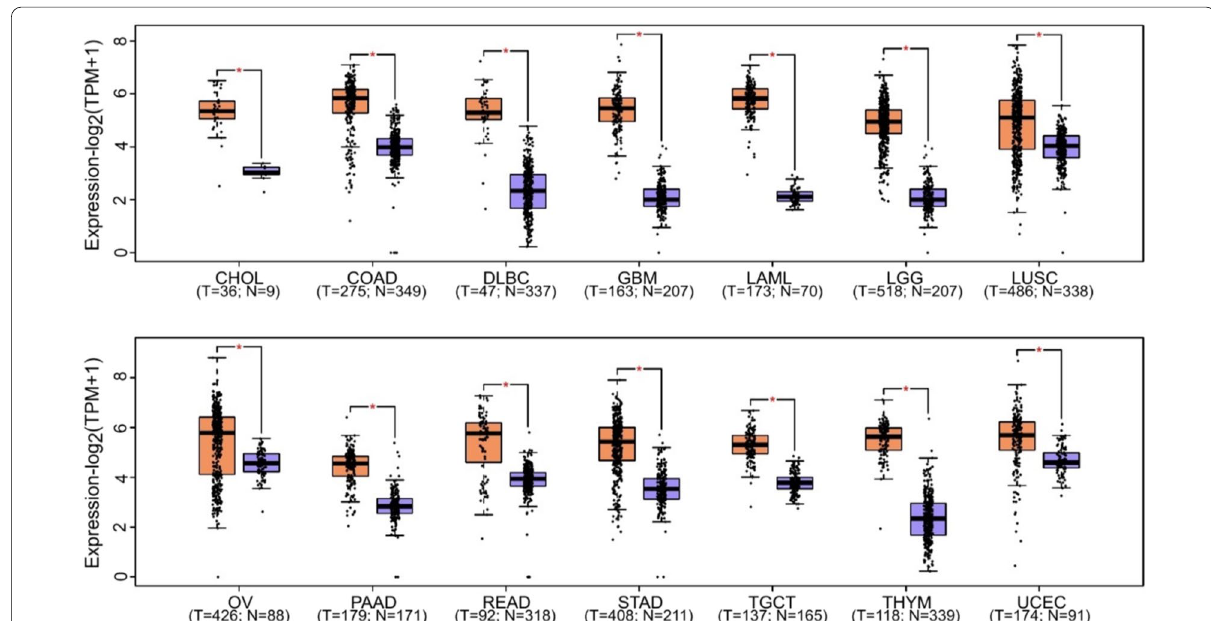
Fig. 6 Differential expression analysis of P53 in CHOL, COAD, DLBC, GBM, LAML, LGG, LUSC, OV, PAAD, READ, STAD, TGCT, THYM, and